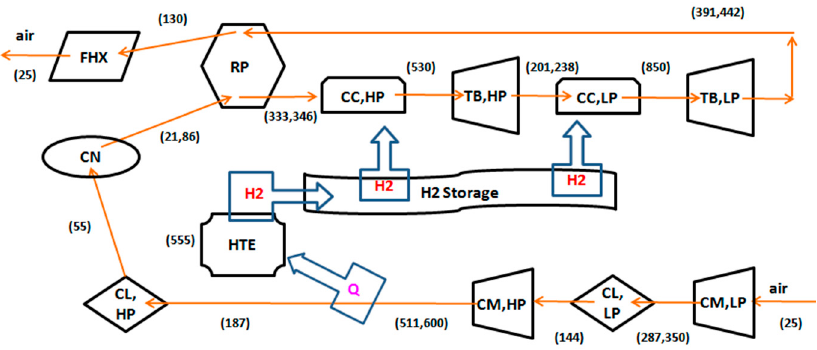
Figure A3. Temperature range of the CAES-HTE system in the base case scenario. Values in each bracket show minimum and maximum temperature. The cavern operates in 5–10 MPa range. The compressor and expander stages have equal pressure ratios.